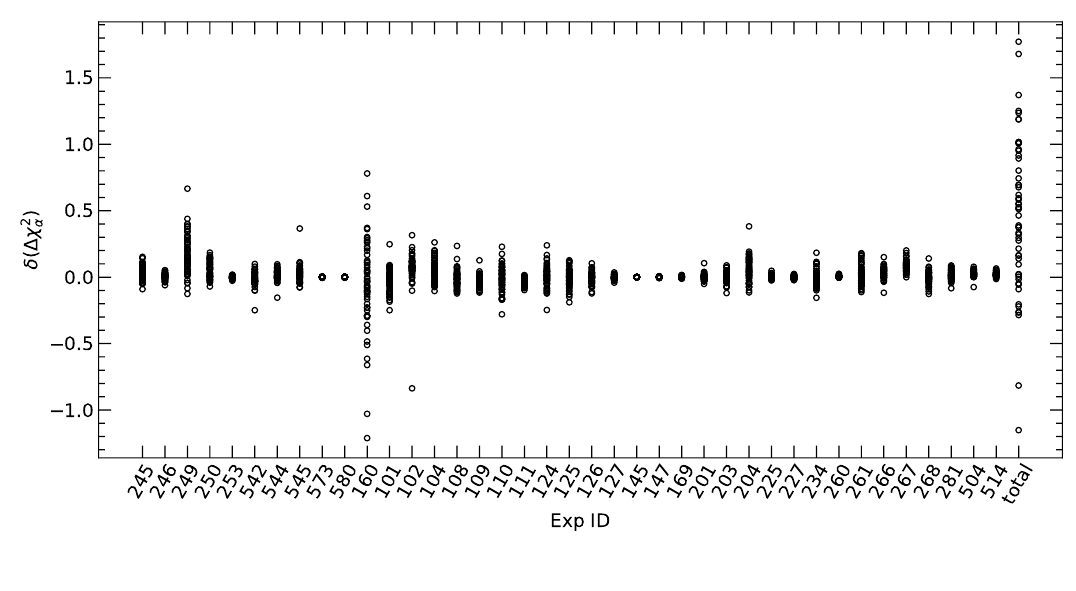
) corresponding to the 56 error PDFs of CT18 NNLO are represented by Figure 3 . The δ (∆ χ 2 α the 56 marks distributed along the vertical direction for each individual data set and for the full data